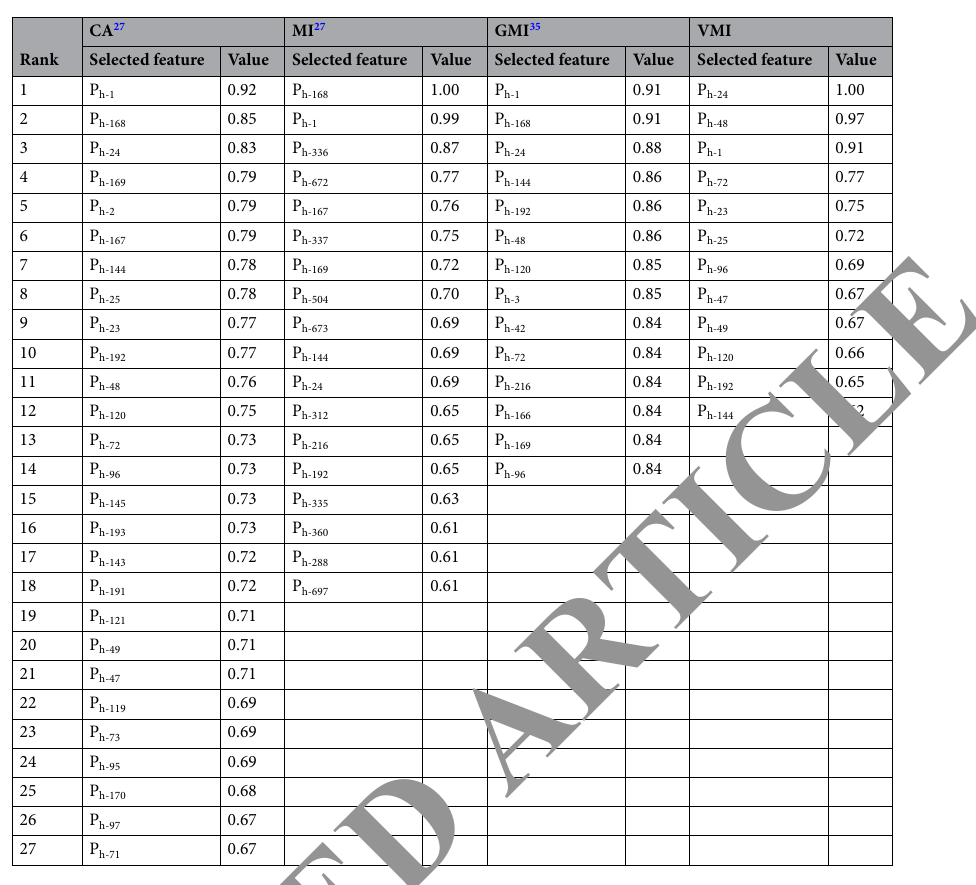
Table 1. Selected features and proposed VMI methods for Spanish market. All results are normalized with respect to their minimum and maximum values and P h-T shows selected price in hour T , columns 2, 4, 6 and 8 are selected features and columns 3, 5, 7 and 9 are their values,